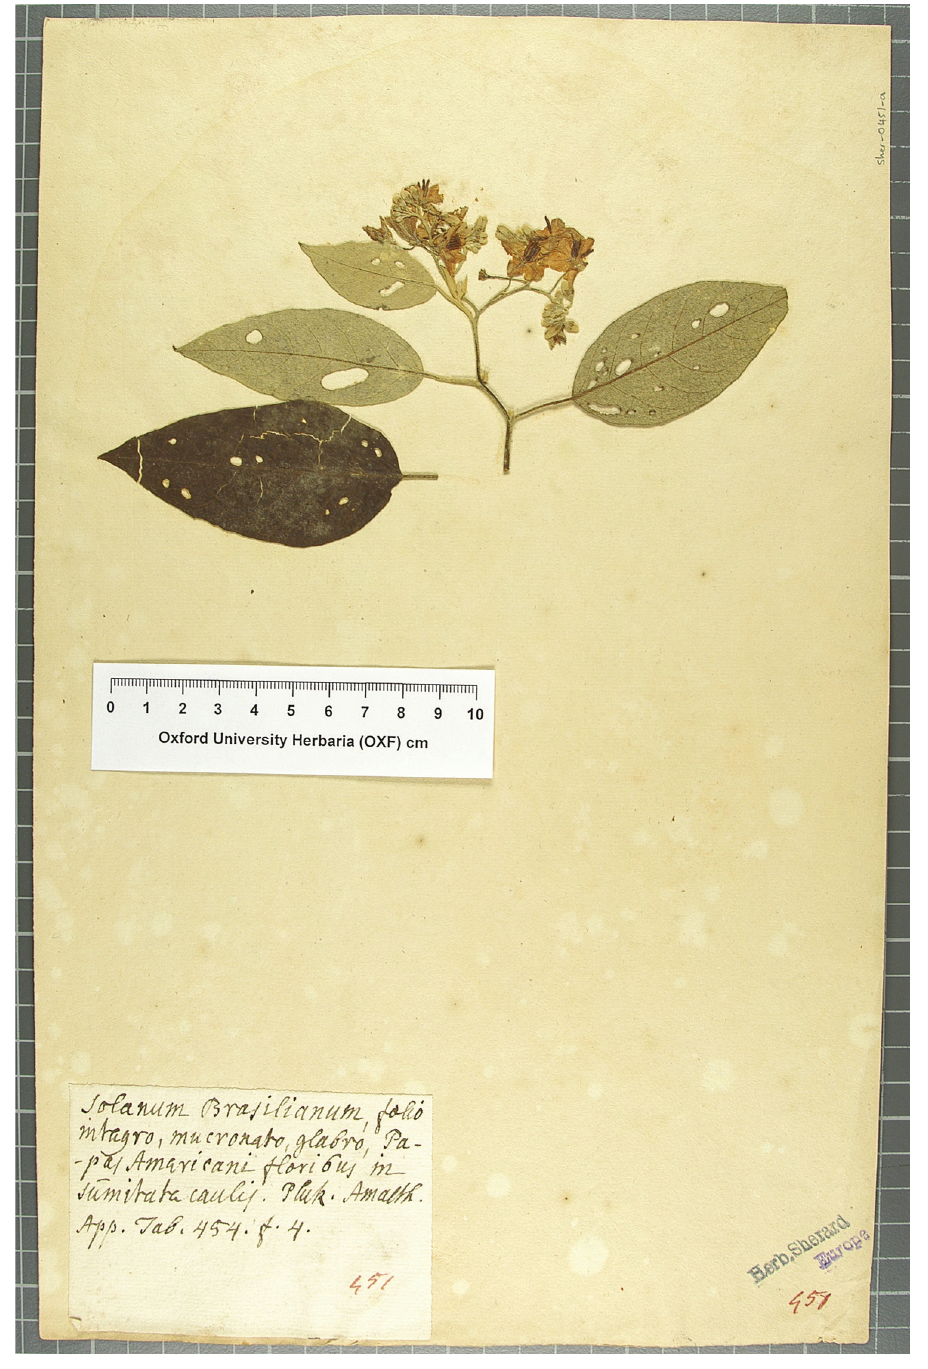
Figure 2. Brazil. Bahia: Salvador, April-May 1699, W. Dampier “herb. Dampier no. 451” (epitype, designated here: OXF!